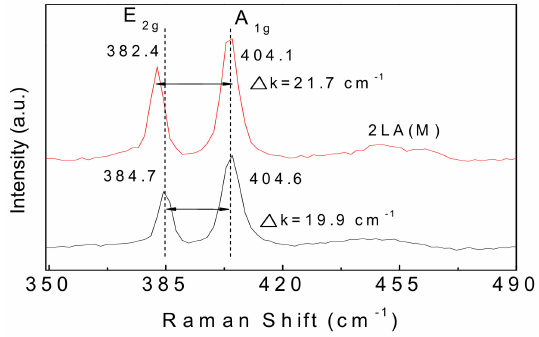
Figure 5. Typical Raman spectra of MoS 2 samples grown on Mn/SiO 2 /Si substrate (red line) and SiO 2 /Si substrate (black line), respectively.